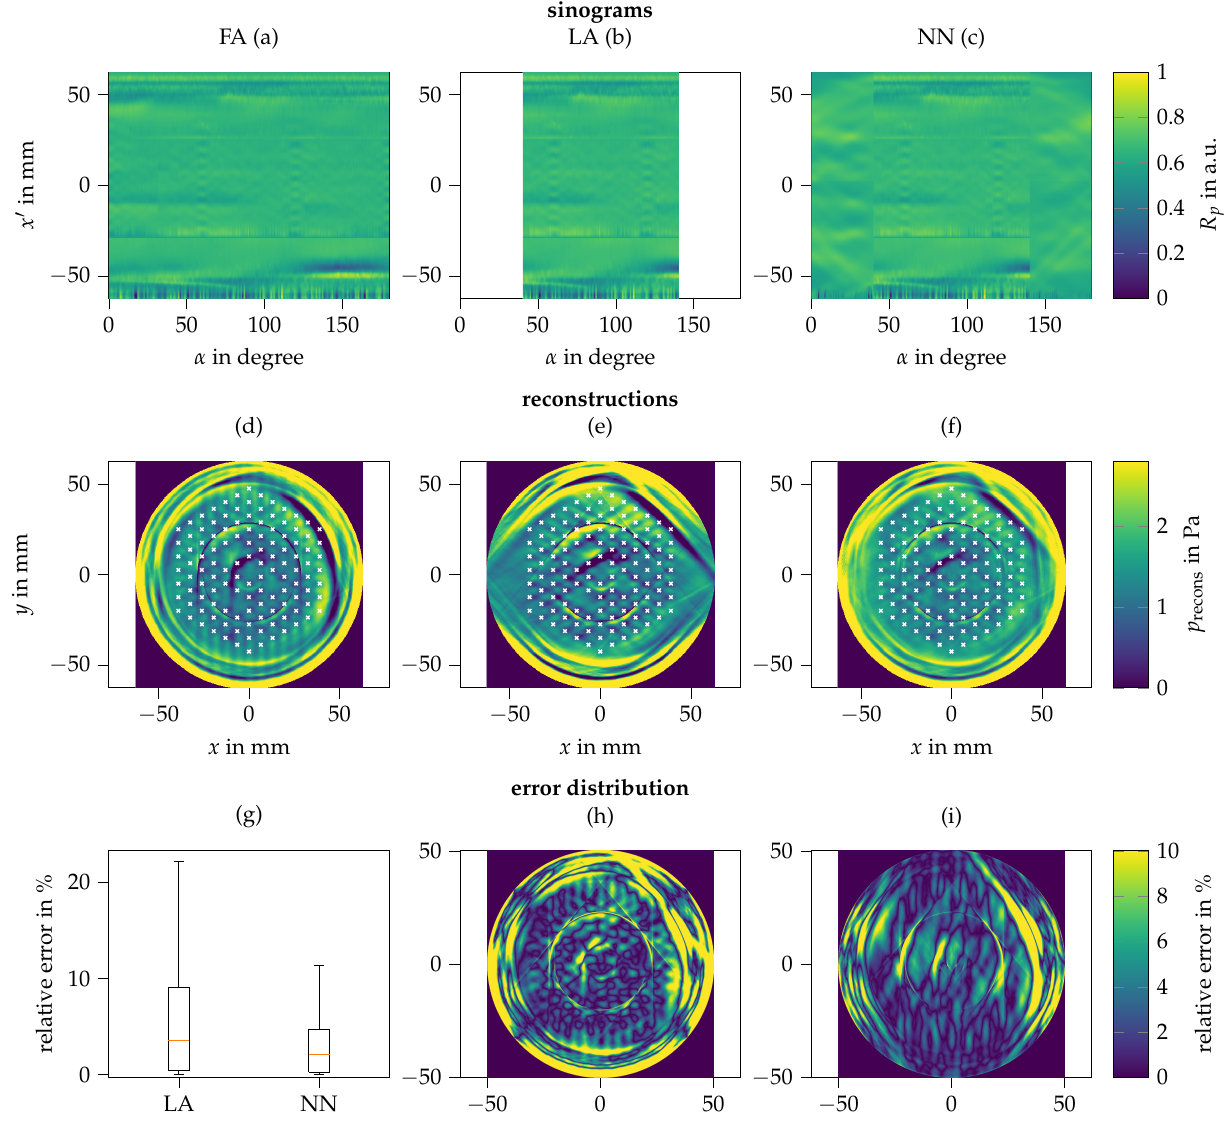
Figure 11. Measured sound pressure field reconstruction: ( a ) full angle (FA) sinogram; ( b ) limited angle (LA) sinogram; ( c ) neural network (NN) extrapolated sinogram; ( d ) full angle filtered back projection tomographic reconstruction; ( e ) lim- ited angle filtered back projection tomographic reconstruction; ( f ) neural network extrapolated filtered back projection tomographic reconstruction; ( g ) error distribution of local reconstructions compared to full angle reconstruction; ( h ) local error of limited angle reconstruction compared to full angle reconstruction; ( i ) local error of neural network reconstruction compared to full angle